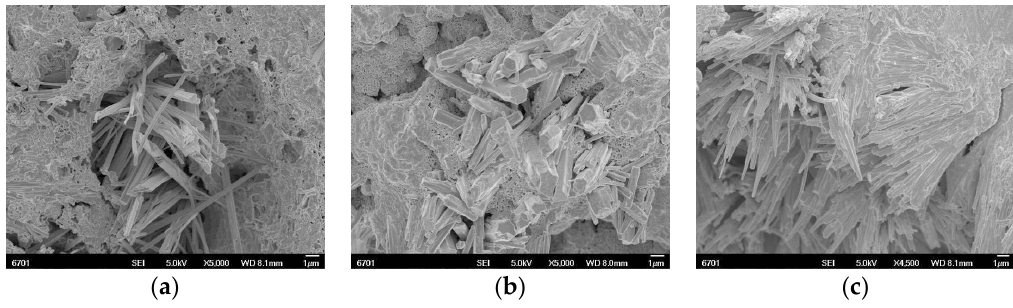
Figure 5. SEM photograph of reinforced concrete with different copper tailings with 206 h corrosion time. ( a ) Group P10; ( b ) Group P20; ( c ) Group P30.